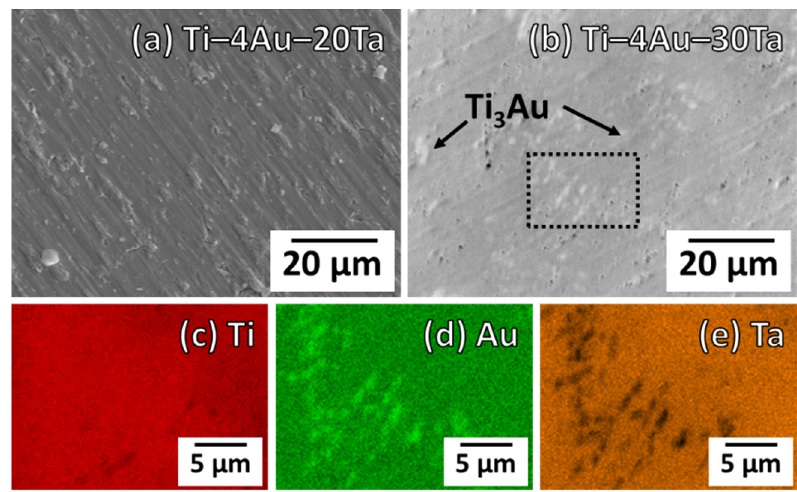
Figure 2. SEM images of the ( a ) Ti–4Au–20Ta alloy and the ( b ) Ti–4Au–30Ta alloy. Elemental mapping results of ( c ) Ti, ( d ) Au, and ( e ) Ta elementals of the ( b ) Ti–4Au–30Ta alloy. The elemental mapping analyzed regime of the ( b ) Ti–4Au–30Ta alloy is surrounded by a dashed square.